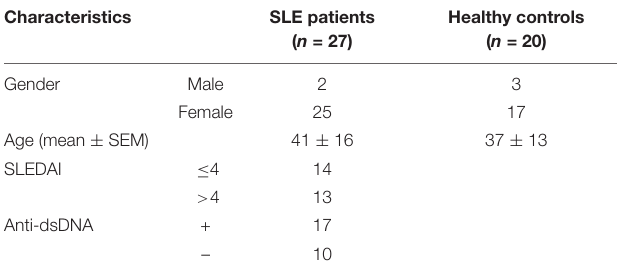
TABLE 1 | Clinical characteristics of patients and healthy